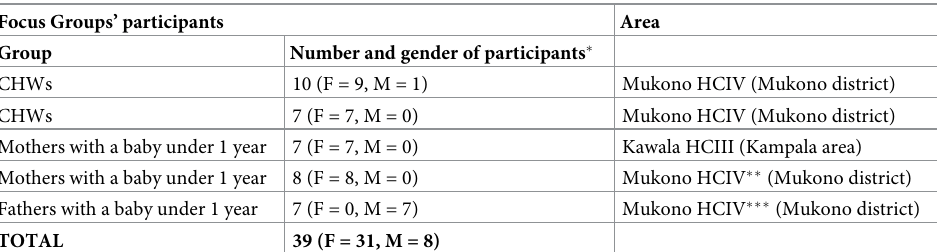
Table 1. Characteristics of focus groups (FGs) sessions.